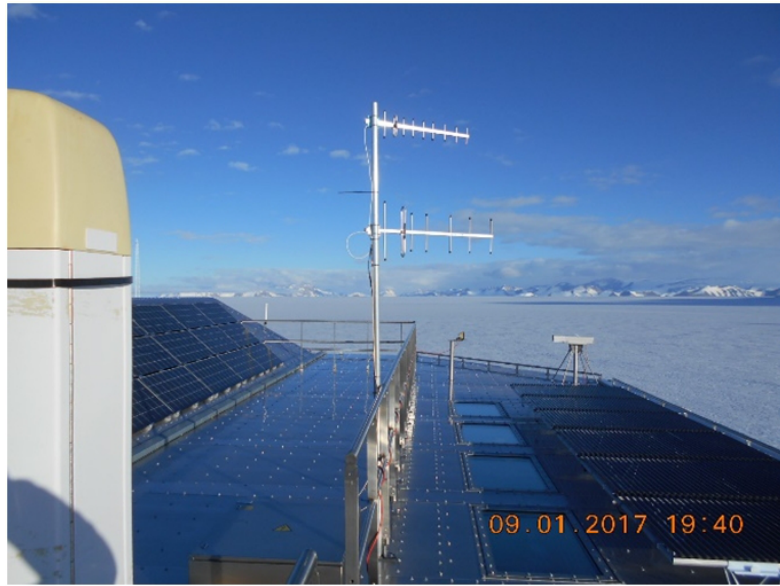
Figure 4. Fixed base station setup with directional antennas for the 434 and 868 MHz bands.